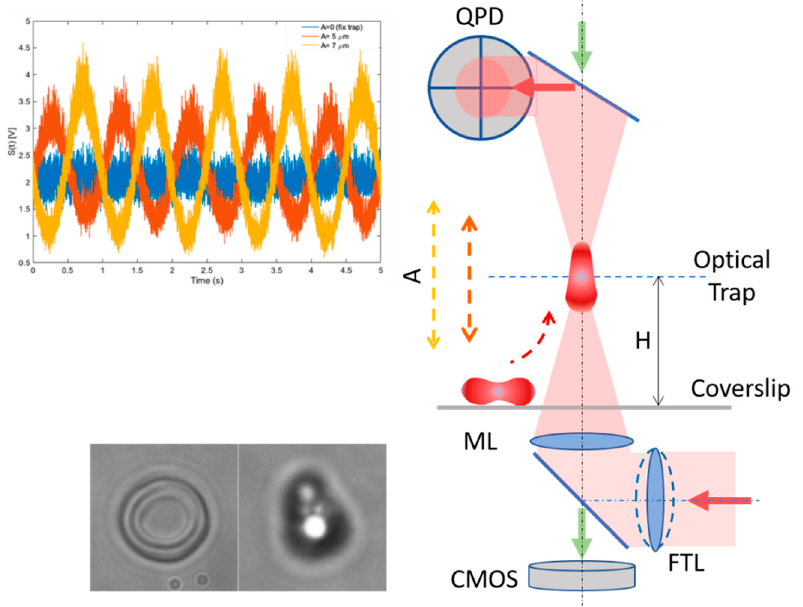
Figure 1. Schematic of the oscillatory optical tweezer (OOT) setup. The red blood cell (RBC) is picked up from the coverslip into the optical trap by the trapping IR laser (red arrows). Cell imaging (bottom left inset) is done by the microscope lens (ML) on the sensor of a CMOS camera by up–down illumination (green arrows) while the intensity fluctuations of the light scattered by the cell are recorded on the Quadrant Photo Detector QPD (top left inset). Using the focus tunable lens (FTL), the position of the optical trap is moved vertically in an oscillatory motion (lens with dotted line illustrates the change of the FTL curvature).